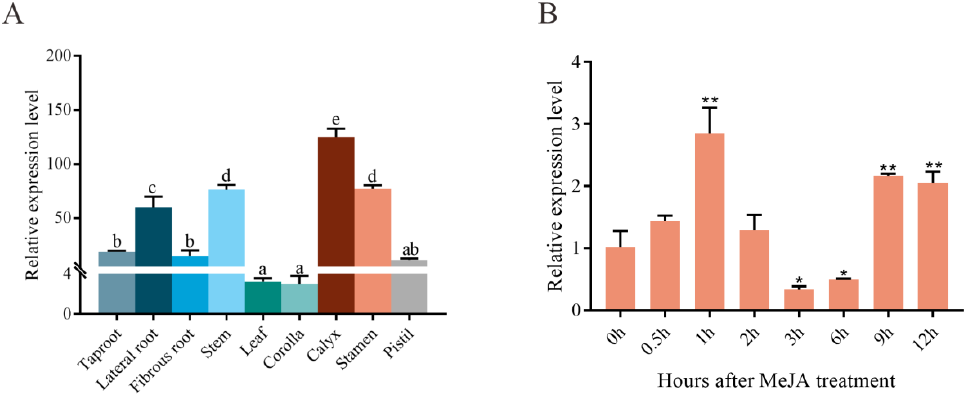
Figure 6. Expression patterns of SmLAC3. ( A ) qRT-PCR analysis of SmLAC3 expression in various S. miltiorrhiza tissues. Different lowercase letters indicate significant differences at p < 0.05 by one-way ANOVA with Tukey’s multiple comparisons test. ( B ) SmLAC3 expression in response to a 100 μM MeJA treatment. All data represent the means of three biological replicates, with error bars indicating SD. Significant differences were determined by Dunnett’s multiple comparison test (** p < 0.01; * p < 0.05).